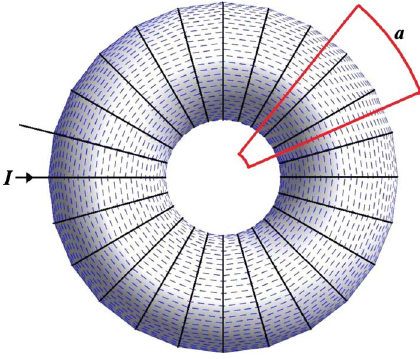
FIG. 6. (cid:1) Color (cid:2) The toroid problem: Find the magnetic field of a toroid with a long wire wrapped around it with n closely spaced turns per unit length, a steady current I , and radii as indicated in the figure. Adapted from example 5.10 in Griffiths (cid:4) 11 (cid:5) . The Ampèrian loop a shown above was not given